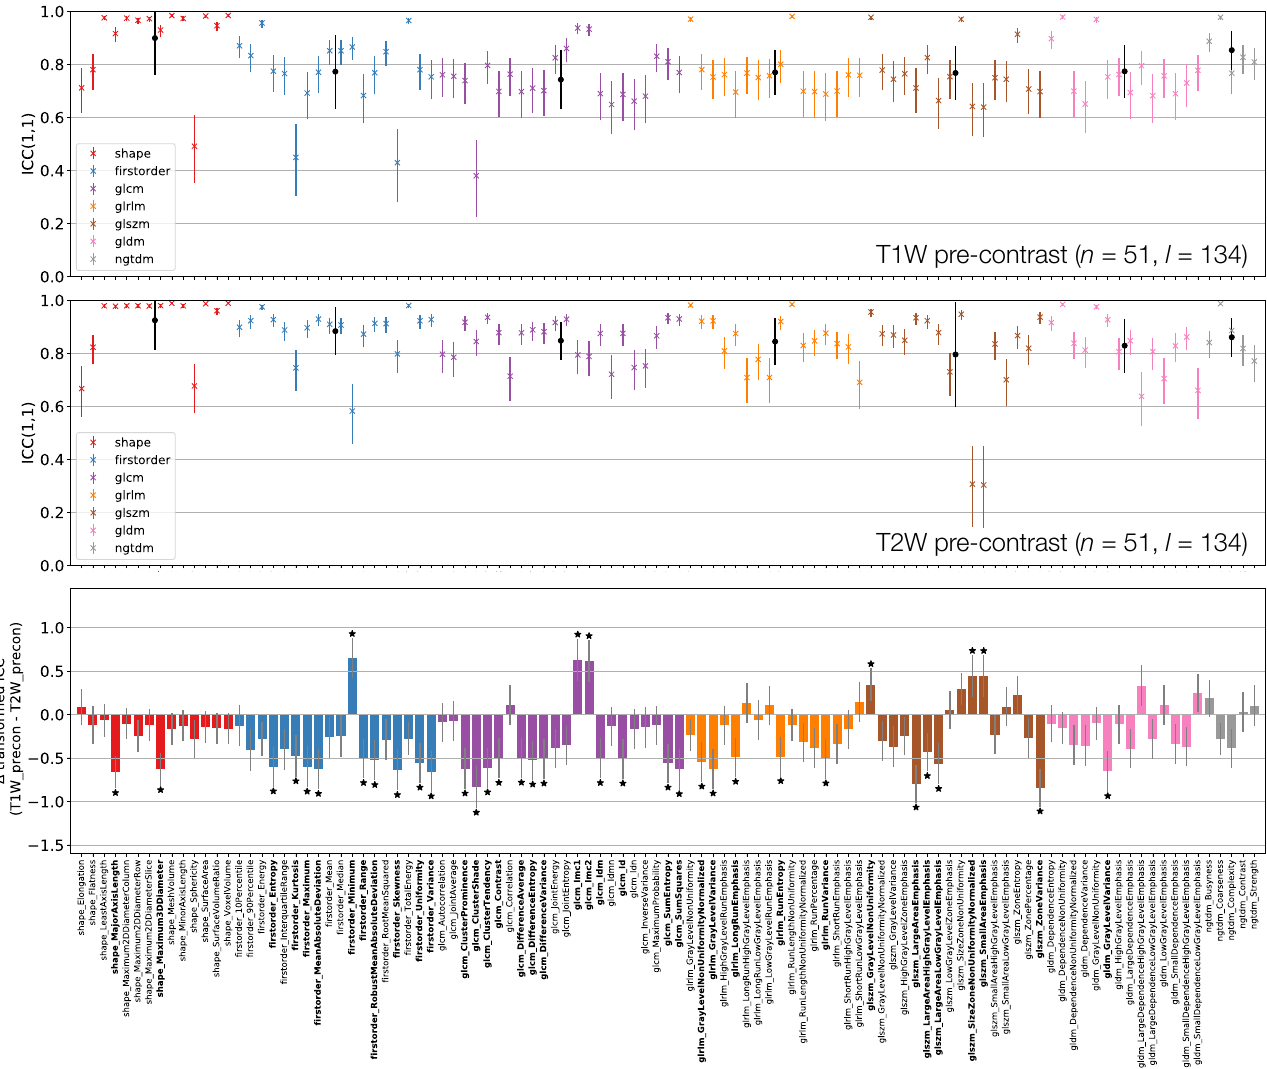
Figure 6. ICCs for Box–Cox transformed features from T 1 W (top) and T 2 W (middle) pre-contrast images. Data points and error bars represent ICC point estimates and 95% CIs. Features are colour coded according to their class and black points correspond to mean ± standard deviation ICCs over features within each class. The bottom panel represents the difference in ICCs (after applying Fisher’s Z -transformation) for T 1 W and T 2 W pre-contrast images. Black stars and bold fonts indicate features where ICCs from the two sequences are significantly different.